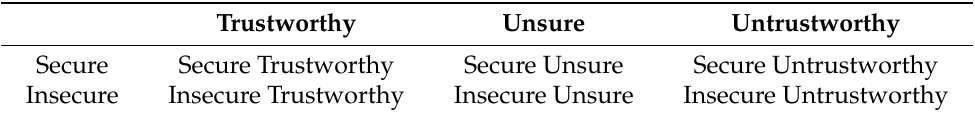
Table 1. Possible participant